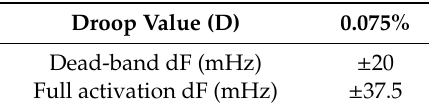
Table 1. Droop curve